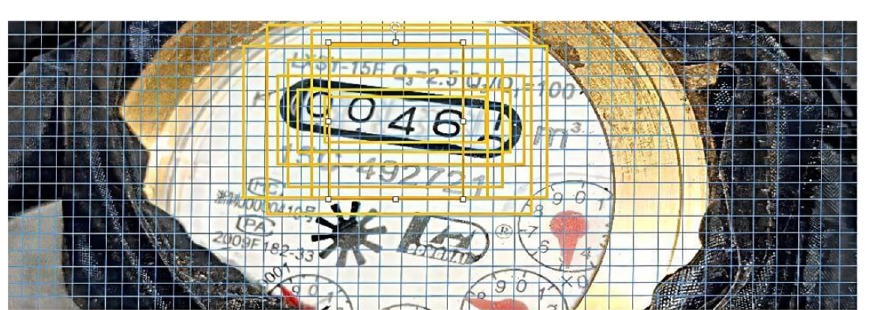
Figure 5. Effect of water meter image target box.